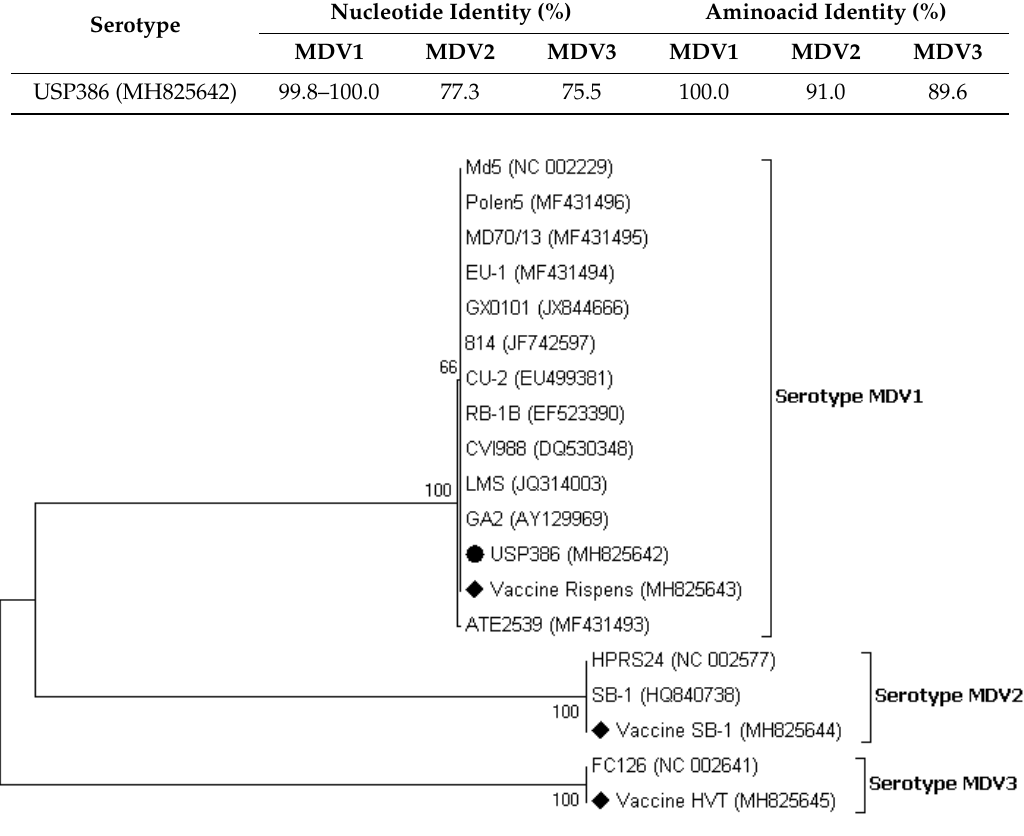
Figure 3. Phylogenetic analysis of the nucleotide sequences of the MDV strains based on the partial gB gene. The strain names and GenBank accession numbers are shown. The black circle represents the field MDV strain used in this study. The black rhombus represents the MDV vaccinal control strains. The phylogenetic tree was constructed in MEGA v7.0 using the Neighbor-Joining method with 1000 bootstrap replicates. The evolutionary distances were computed using the Kimura 2-parameter model (K2 + G + I), and the scale bar represents the number of base substitutions per